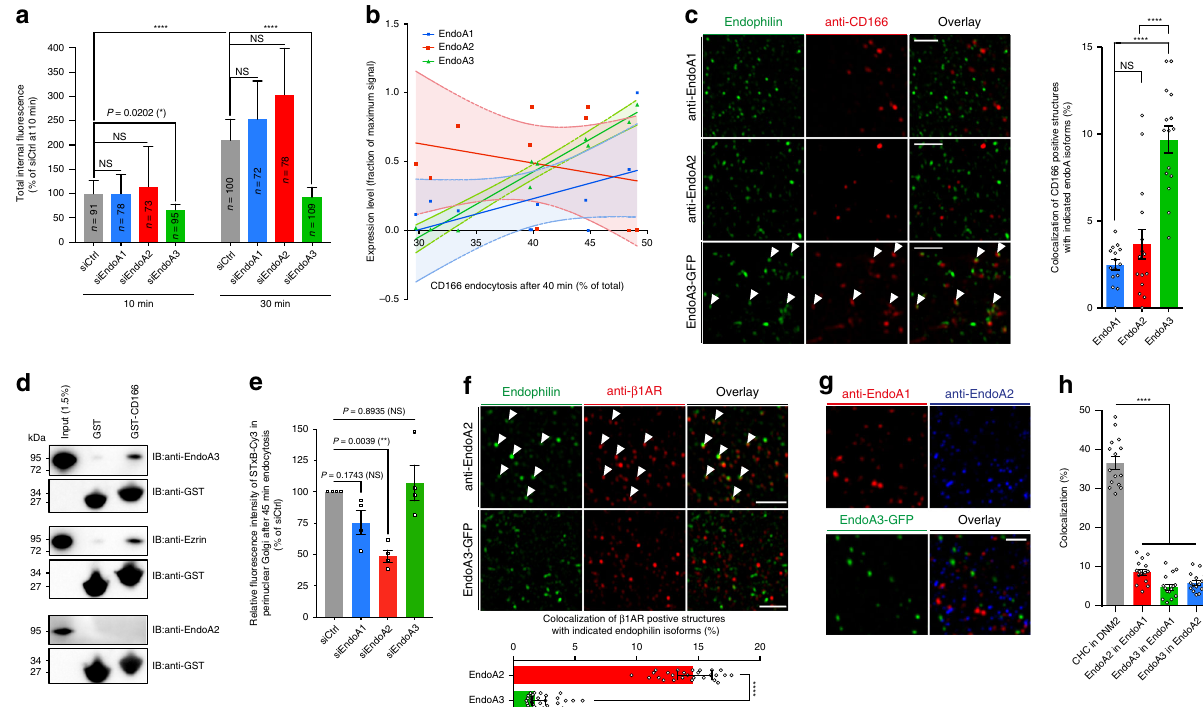
Fig. 2 Endophilin-A3 controls the clathrin-independent uptake of CD166. HeLa ( a – e , g , h ) or BSC-1 ( f ) cells treated with siRNAs or transfected with GFP constructs, as indicated. a , b , e , Treatment with negative control (siCtrl) or endoA1, A2, or A3 (siEndoA1, siEndoA2, or siEndoA3) siRNAs. c , f – h , Immunodetection of endogenous endoA1 and endoA2 with isoform-speci fi c antibodies, or stable low-level expression of endoA3-GFP. a Continuous uptake of anti-CD166 antibody for 10 and 30 min. Internal fl uorescence quanti fi ed from confocal images and plotted as the relative percentage of siCtrl condition at 10 min. n cells, two independent experiments. NS, not signi fi cant. * P < 0.05, **** P < 0.0001 (Kruskal – Wallis test with Dunn ’ s multiple comparison post hoc test, two-sided). b Correlations between the percentage of anti-CD166 endocytosis (after 40 min, Supplementary Fig. 3a) and the relative expression level of individual endoA1 (blue), A2 (red), and A3 (green) isoforms (quanti fi ed from blots, Supplementary Fig. 3b). c Airyscan images of cells fi xed after 10 min of incubation with anti-CD166 antibody (red). White arrows, co-localization. Graph, quanti fi cations of co-localization ( n = 15 cells, three independent experiments). NS, not signi fi cant. **** P < 0.0001 (ordinary one-way ANOVA with Bonferroni ’ s multiple comparison test). d Pull-down experiments with cytosolic tail of CD166 on endoA3-GFP- or endoA2-GFP-expressing cell lysates. Negative control, GST alone. Positive control, ezrin. Representative of four independent experiments. e Incubation for 45 min at 37 °C with 50 nM STxB-Cy3. Fluorescence intensity in perinuclear Golgi quanti fi ed from tiled wide- fi eld images, and normalized to siCtrl condition. Number of cells: siCtrl, n = 5918; siEndoA1, n = 6147; siEndoA2, n = 4791; siEndoA3, n = 6290. Four independent experiments. NS, not signi fi cant. ** P < 0.01 (ordinary one-way ANOVA with Dunnett ’ s multiple comparison test and a single pooled variance). Representative images, Supplementary Fig. 7a. f Uptake of β 1-adrenergic receptor ( β 1-AR) after addition of 10 µ M dobutamine for 4 min at 37 °C. β 1-AR (red) and endoA2 or endoA3 (green). Graph, quanti fi cations of co-localization ( n = 30 cells, three independent experiments). **** P < 0.001 (two-tailed Mann – Whitney test). g , STED images of endoA isoforms (A1, red; A2, blue; A3, green). Equivalent confocal images, Supplementary Fig. 7c. h , Quanti fi cation of co-localization of endoA isoforms from confocal images (Supplementary Fig. 7c). Positive control, clathrin heavy chain, (CHC) and dynamin-2 (DNM2). Number of cells per condition: n = 15. Three independent experiments. **** P < 0.0001 (ordinary one-way ANOVA with Dunnett ’ s multiple comparison test). Scale bars, 2 µ m ( c , f ) and 1 µ m ( g ). Data are mean ± s.e.m. ( c , e , h ), mean ± 95% CI ( b ), or median ± 95% CI ( a , f ). Source data are provided as a Source Data fi le and in Supplementary Fig. 11